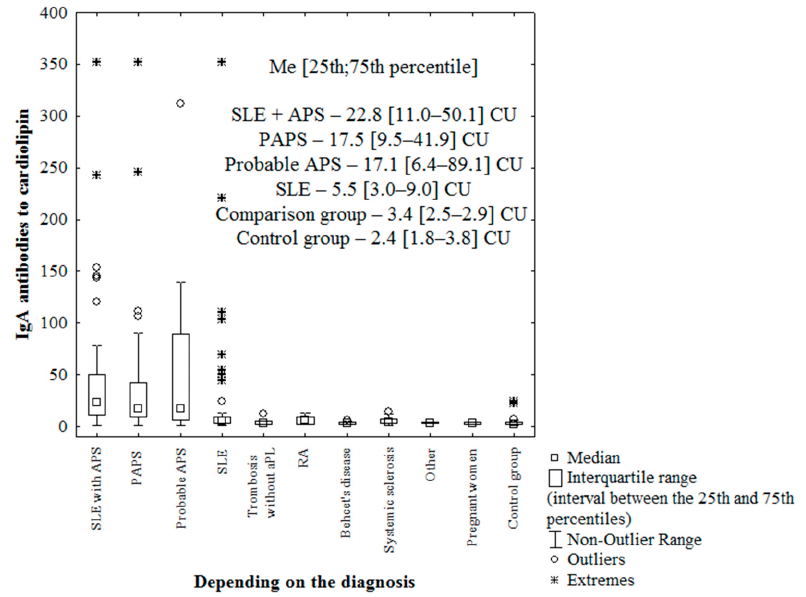
Figure 1 . Levels of IgA antibodies to cardiolipin (IgA aCL) in patient groups. Note: SLE-systemic lupus erythematosus; APS-antiphospholipid syndrome; aPL-antiphospholipid antibodies; RA- rheumatoid arthritis; other-two patients with polymyositis, one of whom had thrombosis and one patient with Buerger's endarteritis; Me-median with interquartile range; CU-chemiluminescent units; and the Y axis shows units-CU-chemiluminescent units (IgA aCL unit). According to IgA aCL positivity, all patients were divided into two groups: 1) 75 patients with positive values ( > 18.9 CU) and 2) 112 with negative values (< 18.9 CU). Verification of definite APS was statistically significantly associated with the positivity for IgA aCL ( χ 2 = 23.96; p < 0.0001) (Table 1). APS was detected in 61 (81%) patients with IgA aCL versus 51 (45%) patients without these antibodies ( χ 2 = 23.96; p < 0.0001; odds ratio (OR), 5.26; 95% confidence interval (CI), 2.63–11.11). The risk of developing APS was 5.26 times higher than that in patients without IgA aCL. There was a significant relationship between IgA aCL and thrombosis ( χ 2 = 4.96; p = 0.02) (Table 1). Thrombosis was recorded in 53 (71%) of 75 patients with IgA aCL ( χ 2 = 4.96; p = 0.02). The risk of thrombosis in the patients with positive IgA aCL was 2.04 times higher than in those without these antibodies. Table 1. Relationship of antiphospholipid syndrome and it is clinical manifestations (thrombosis and pregnancy morbidity with IgA antibodies to cardiolipin (IgA aCL). Parameter IgA aCL (+), n (%)